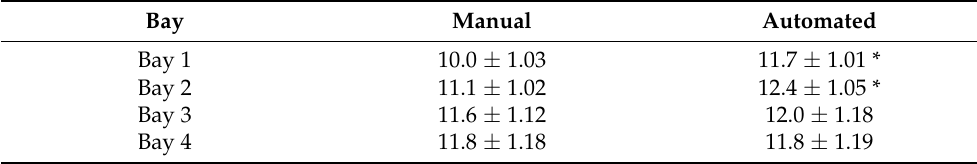
Table 3. Yield monitor results (t/ha) from Site B. Mean values ± standard deviation.